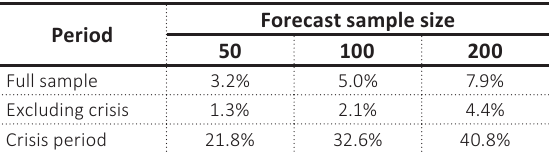
Table 1. Average rejection rate in each period